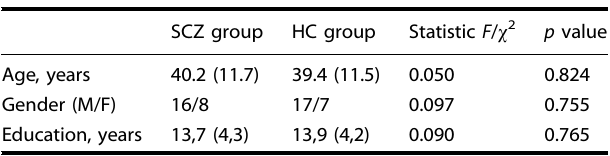
Table 1. Demographic